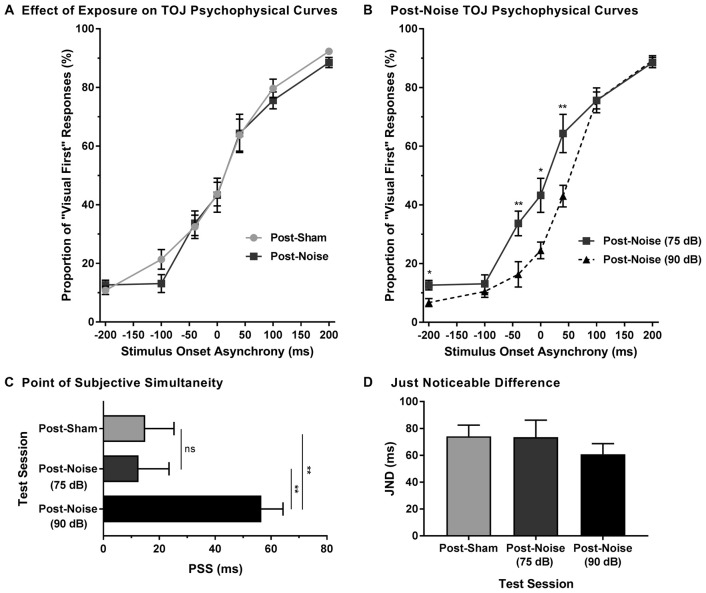
Preserved audiovisual temporal perception following adult-onset hearing loss. (A) Test sessions at 75 dB SPL were completed 2 weeks following exposure to a loud noise (i.e., post-noise) or quiet (i.e., post-sham). (B) An additional test session was completed at 90 dB SPL (i.e., post-noise (90 dB SPL)) and compared to the test session at 75 dB SPL (i.e., post-noise (75 dB SPL)), in order to determine if temporal perception remained sensitive to sound intensity. For all test sessions, performance was plotted as the proportion of trials that the rats perceived as “visual-first” (i.e., responded to the right feeder trough; *p < 0.05, **p < 0.007). (C) The PSS and (D) the JND were derived from each of the test sessions (**p < 0.01, ns = not significant). Results are displayed as mean ± SEM, n = 9.